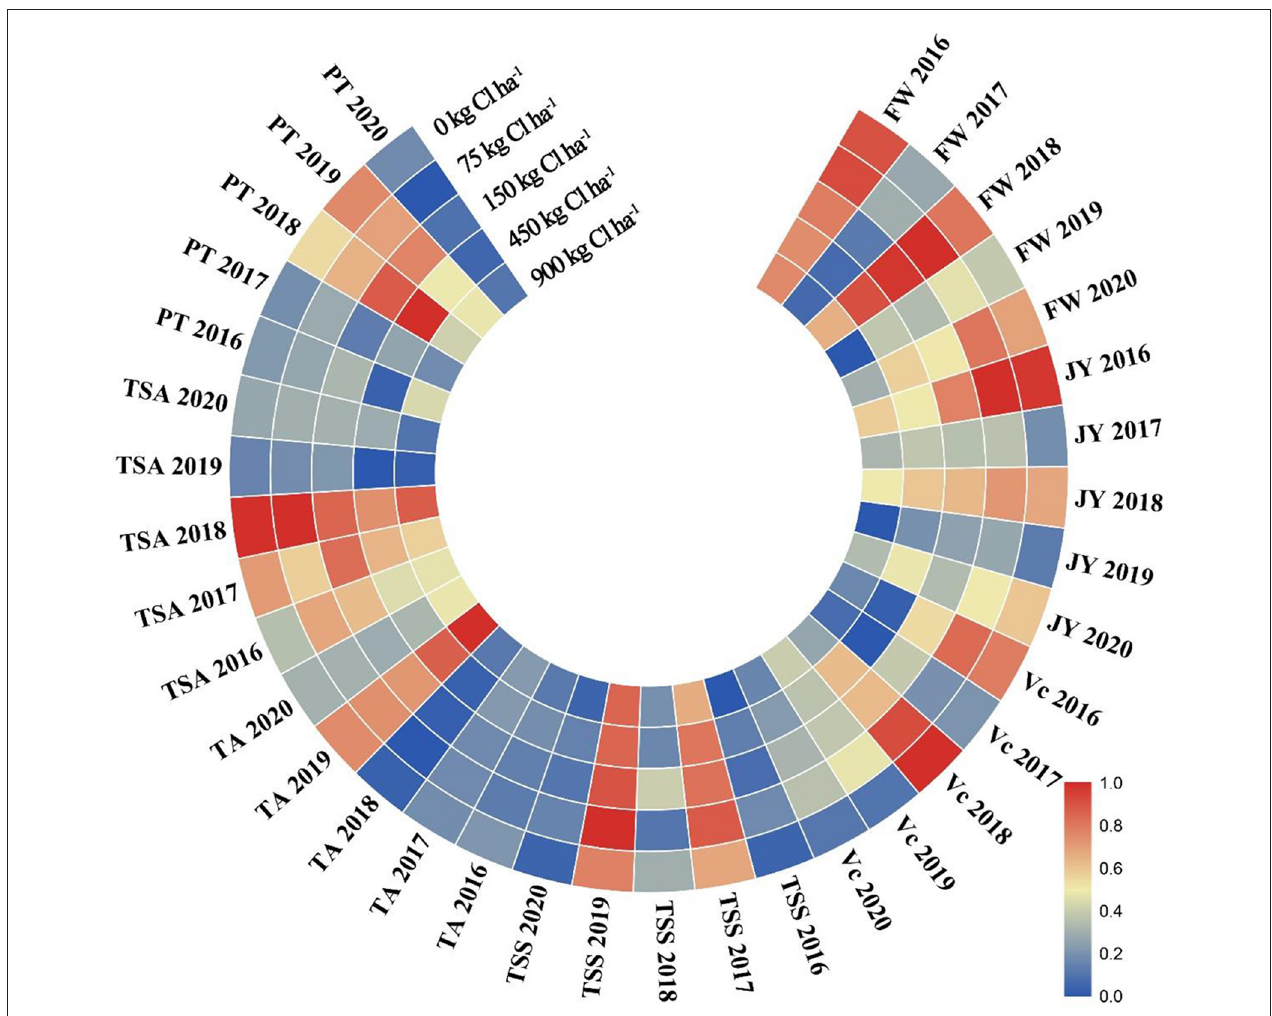
FIGURE 2 | Effects of Cl-containing fertilizer on fruit weight (FW), juice yield (JY), Vc, TSS, TA, TSS/TA (TSA), and peel thickness (PT) of fruit quality in 5-year field experiment from 2016 to 2020. Bars are means of three replicates ± SD. Different letters (a, b, c) in each sub-figure represent significant differences at ( P < 0.05). The data corresponding to this figure is shown in Supplementary Table S1